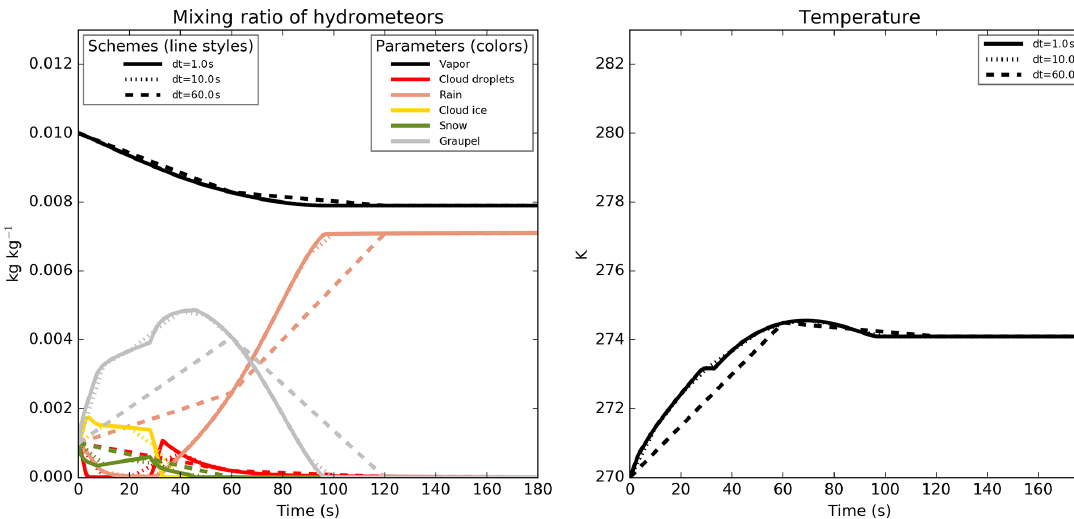
Figure 8. Same as Fig. 1 but using the new version of the microphysical